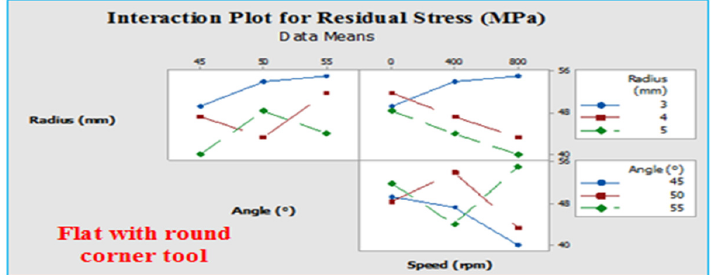
Fig. 12. The interaction between the processes parameters and the residual